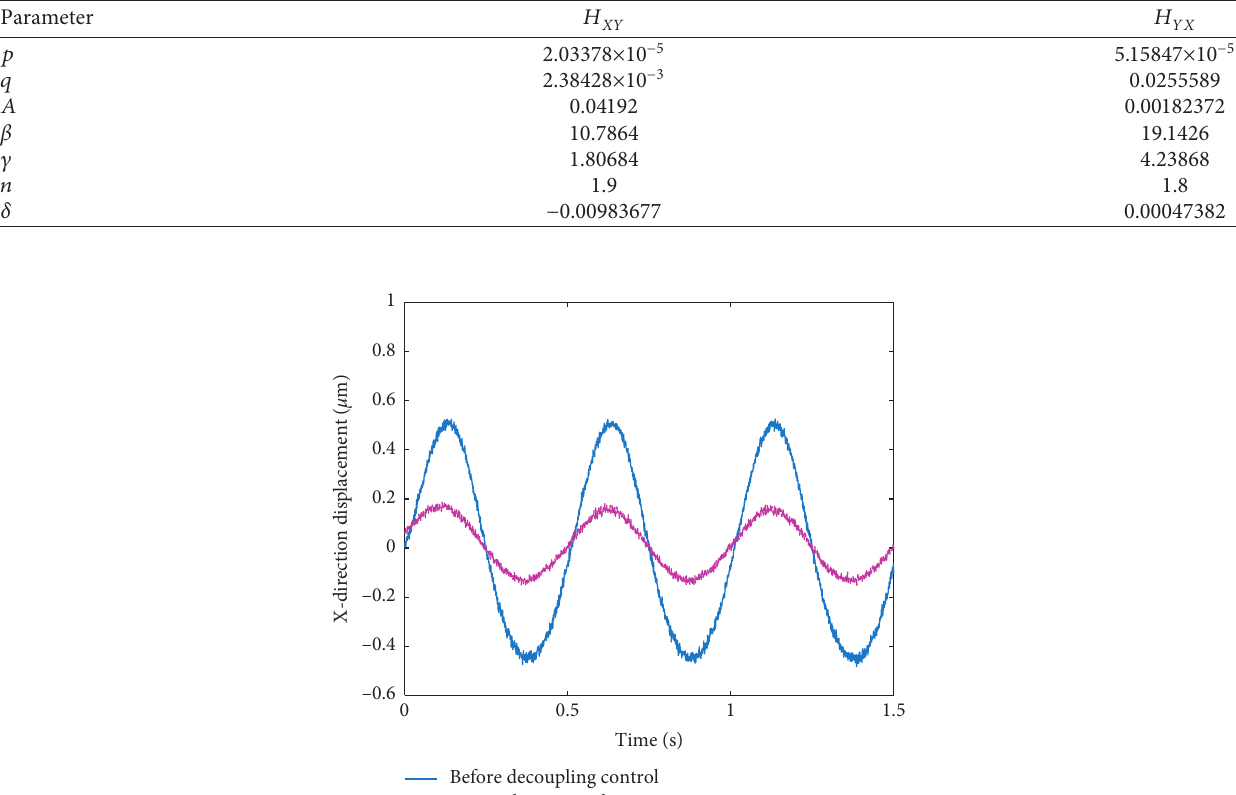
Table 2: Parameter identification results of coupling models in the X - and Y-direction.